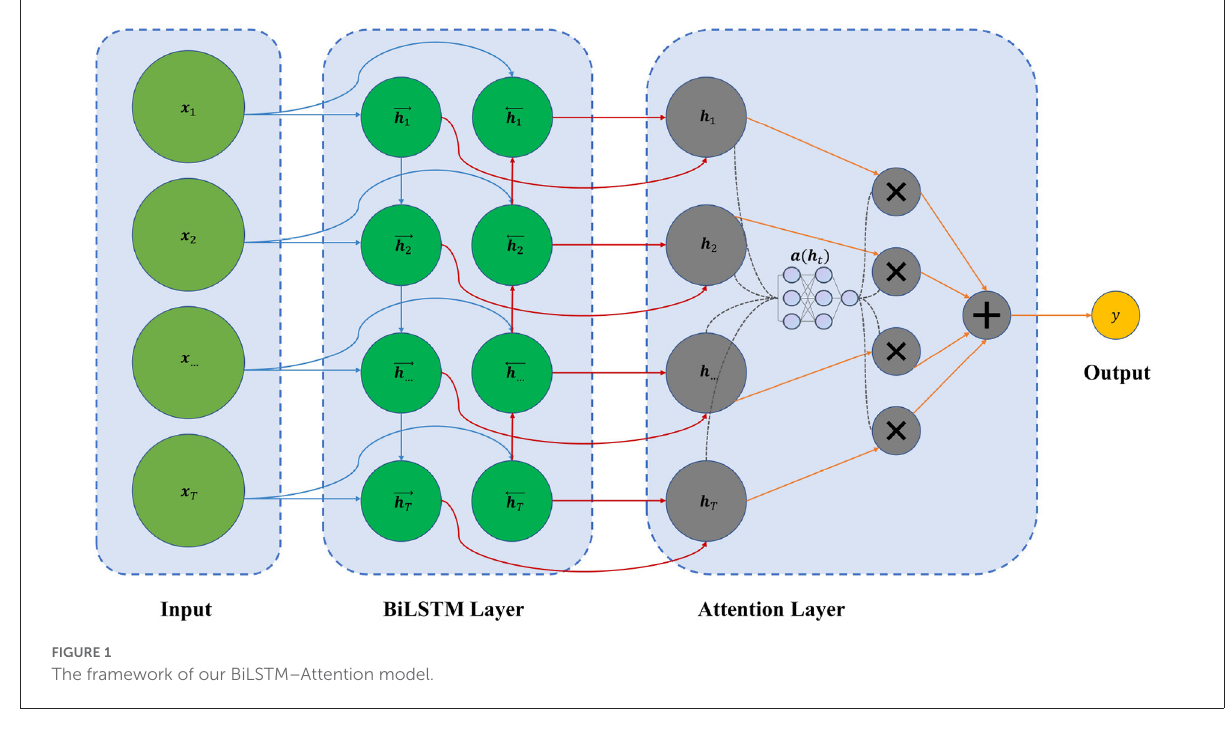
FIGURE1 The framework of our BiLSTM–Attention model.